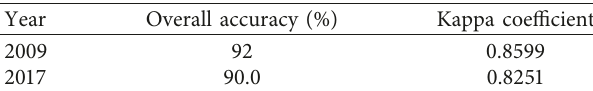
Table 2: Accuracy assessment of classified map in 2009 and